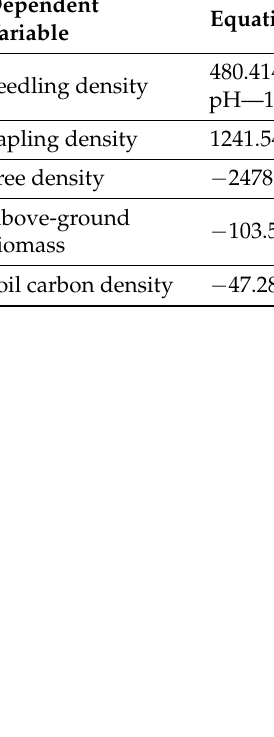
Table 3. Regression analysis between seedling, sapling, tree density (N ha − 1 ), above-ground biomass and soil carbon density and the soil